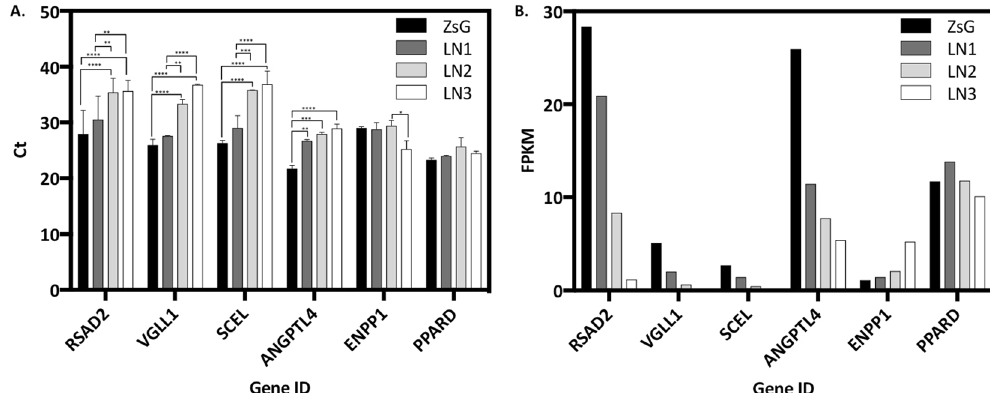
Figure 5. Expression profiles of the selected common DEGs displaying altered-expression for each cell line, of 3 independent experiments. ( A ) RT-PCR data and ( B ) FPKM data. Turkey’s multiple comparisons test,